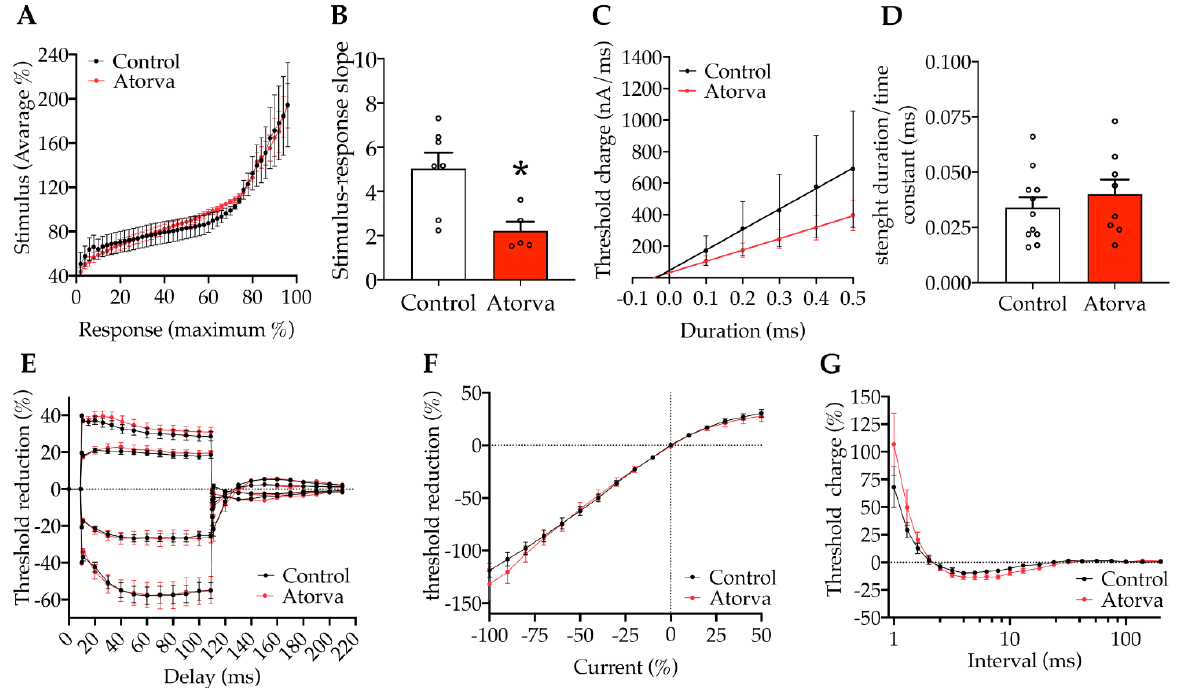
Figure 6. Nerve conduction. Stimulus-response recording shows the relationship between the % of supramaximal compound action potential (CAP) response evoked by crescent current stimuli, normalized for the complex average stimulus applied. Plotted representation of stimulus-response curves ( A ). Stimulus-response outcomes were analysed by comparing sigmoidal’s slope values calculated for each nerve. ( n = 8, unpaired t test * p = 0.0128, t = 3.023, df = 10) ( B ). Strength-duration protocol assesses the total energy of a stimulus required by the fibre to generate an action potential, measured as the current required to elicit 40% of CAP by different stimulus duration. Plotted representation of strength duration outcomes ( C ); from 0.1 ms to 0.5 ms square pulse. The strength-duration time constant ( τ SD ) represents the intercept on the stimulus duration axis. τ SD values as been analysed (Control ( n = 11); Atorva ( n = 8); unpaired t -test n.s. p = 0.4593, t = 0.7572, df = 17 ( D ). In the threshold electrotonus protocol, percent reduction was calculated as the peak of reduction between those obtained before and after subthreshold depolarizing or hyperpolarizing currents, averaged over 20 ms. Four different protocols were used as represented in panel E ( ± 20% and ± 40% currents). 2way ANOVA test was applied to each electrical protocol, comparing control ( n = 10) and atorva ( n = 7). +40% treatment variation p = 0.0509, F (1.420) = 3.833; +20% treatment variation p = 0.2338 F(1.390) = 1.422; − 20% treatment variation p = 0.4477 F(1.390) = 0.5776; − 40% p = 0.9770, F(1.390) = 0.0008 ( E ). In the threshold I/V protocol current-threshold relationship was calculated by comparing conditioned threshold peak measured after 200 ms depolarizing to hyperpolarizing subthreshold current applied to a resting condition. Control ( n = 10), atorva ( n = 7); 2way ANOVA test was applied ( p = 0.2160) ( F ). Recovery cycle protocol was used to assess refractoriness and super excitability as the percentage change in threshold after supramaximal conditioning stimulus at crescent interstimulus intervals. control ( n = 8), atorva ( n = 7); 2way ANOVA test was applied ( p = 0.4472 F(1.268) = 0.5795) ( G ). Control = high-fat high-cholesterol diet; Atorva = high-fat high-cholesterol diet plus atorvastatin.